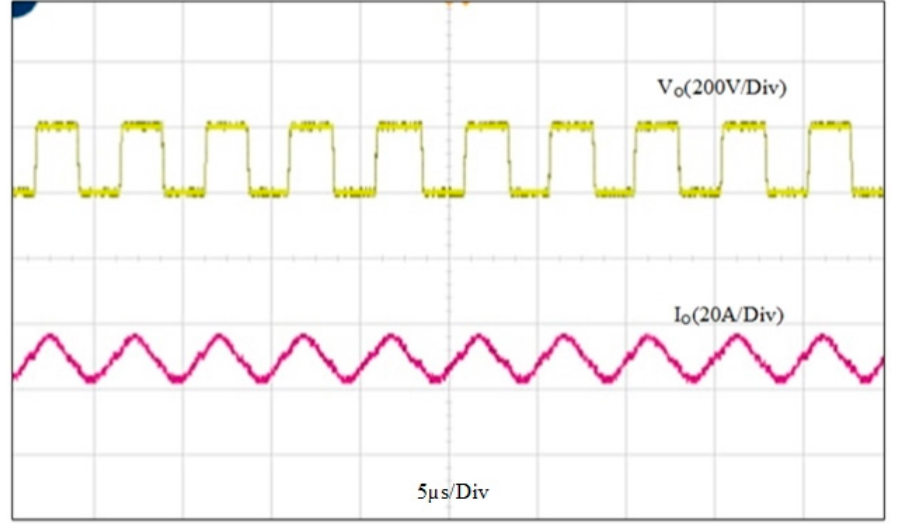
Figure 18. Output waveforms for ferrous heating mode during experiment.